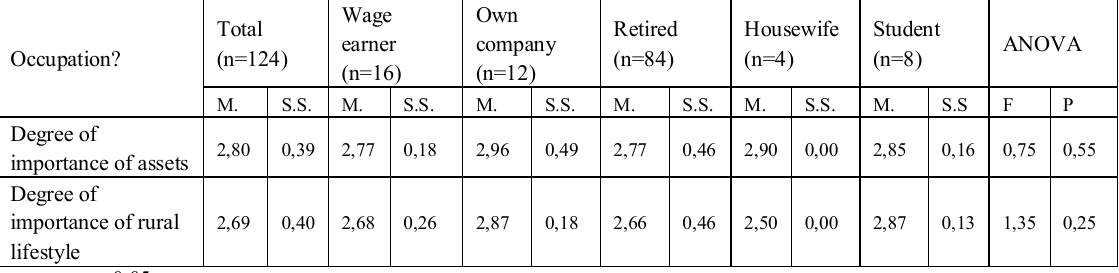
Table 7: Effect of Profession to Different Variables